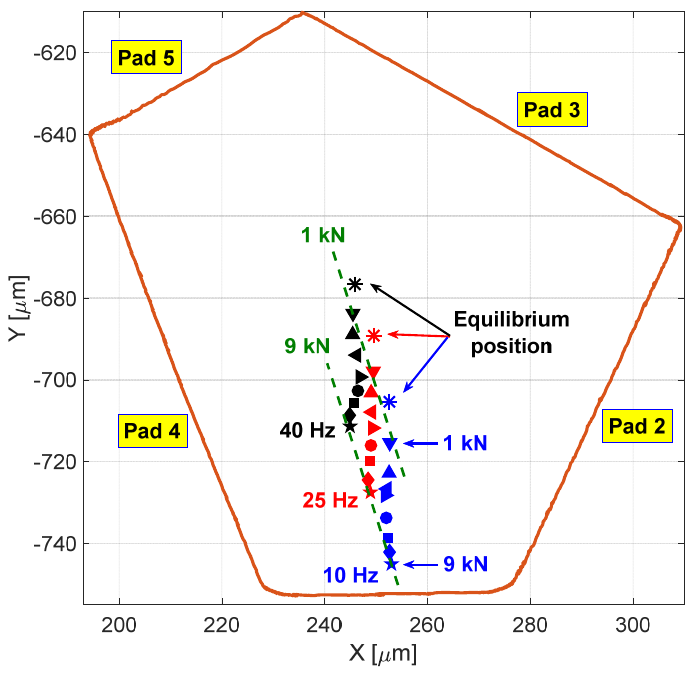
Figure 12. Measured shaft positions at different speeds vs. static load.